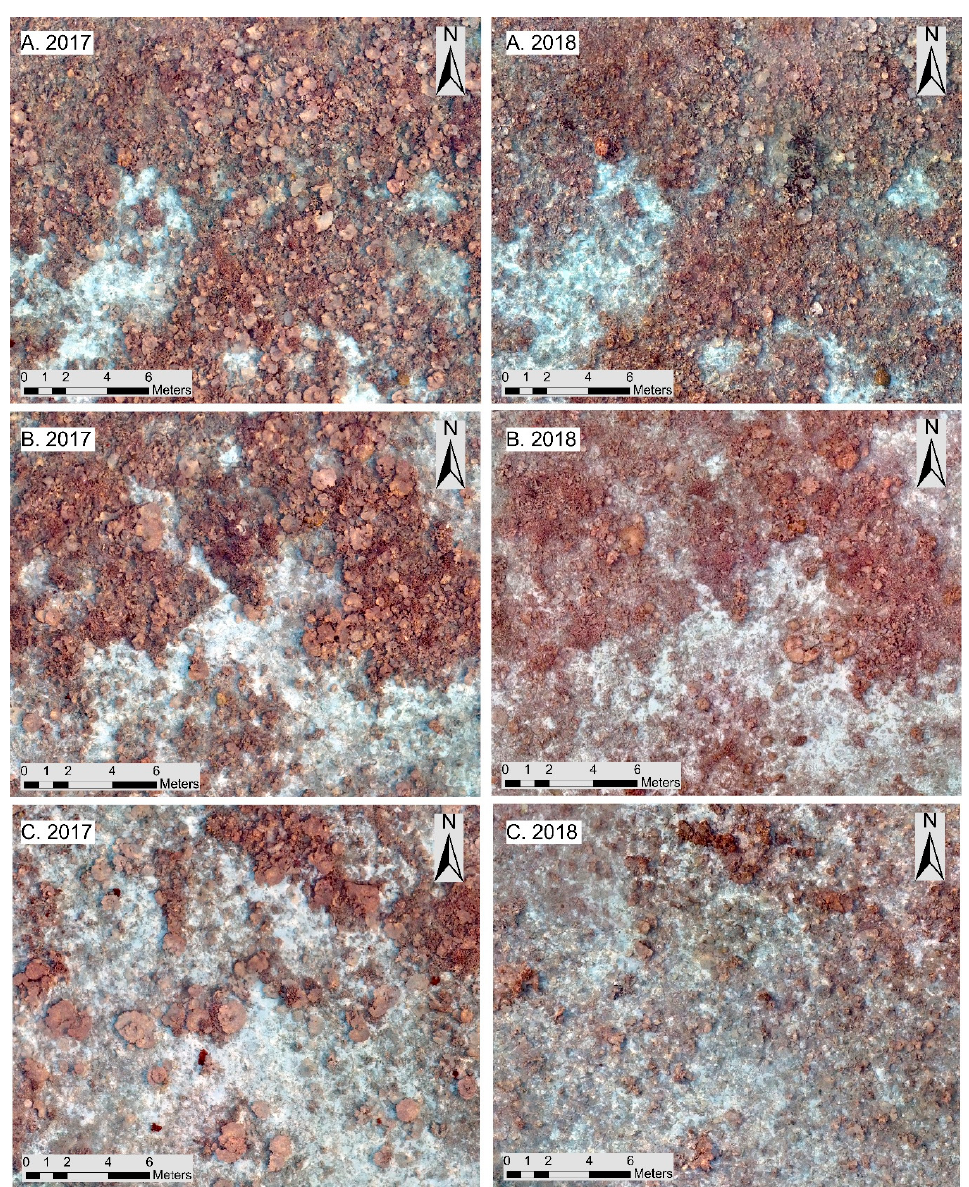
Figure 11. Close-range view of the three zones indicated with yellow arrows ( A–C ) in Figure 6.